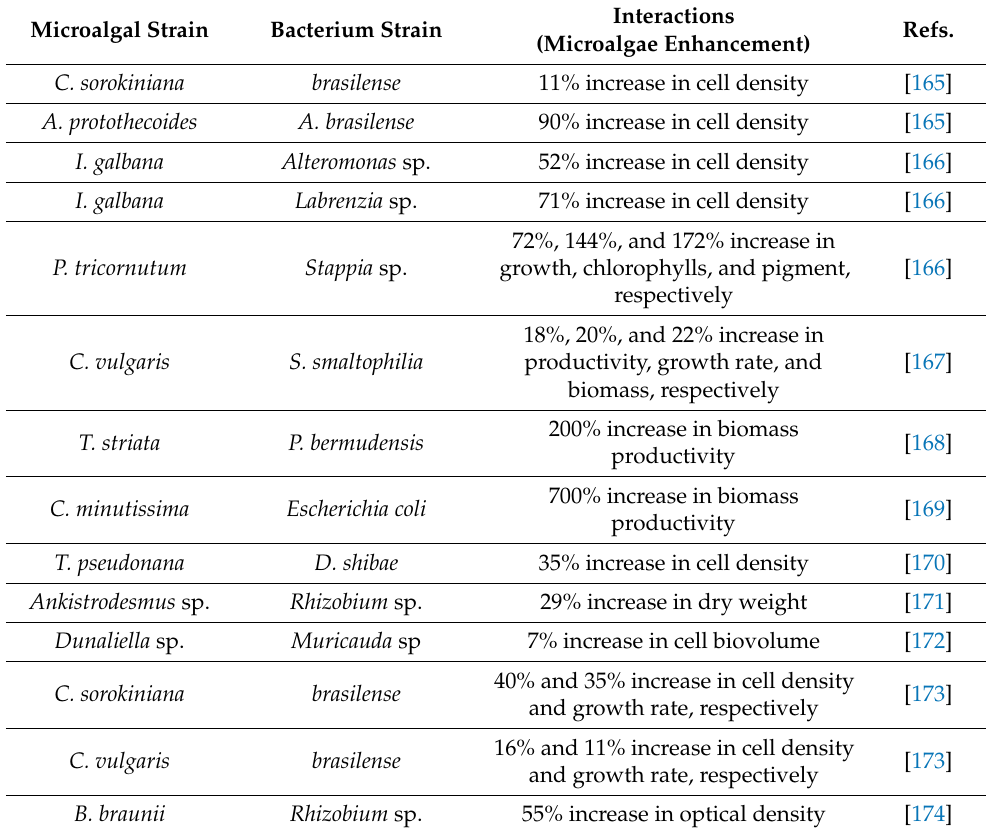
Table 8. Microalgae enhancements as a result of co-cultivation with bacteria. Microalgal